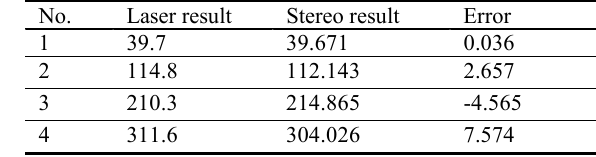
Table 3. Measurement results of the stereo cameras comparing with laser ranging. 3.2.2 Target Detection and Localization Result: